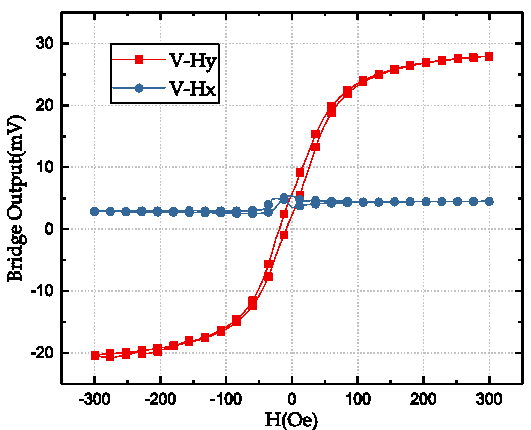
Figure 4. The output of the full Wheatstone-bridge-based GMR sensors under 3 V bias voltage in the x- and y -axes.